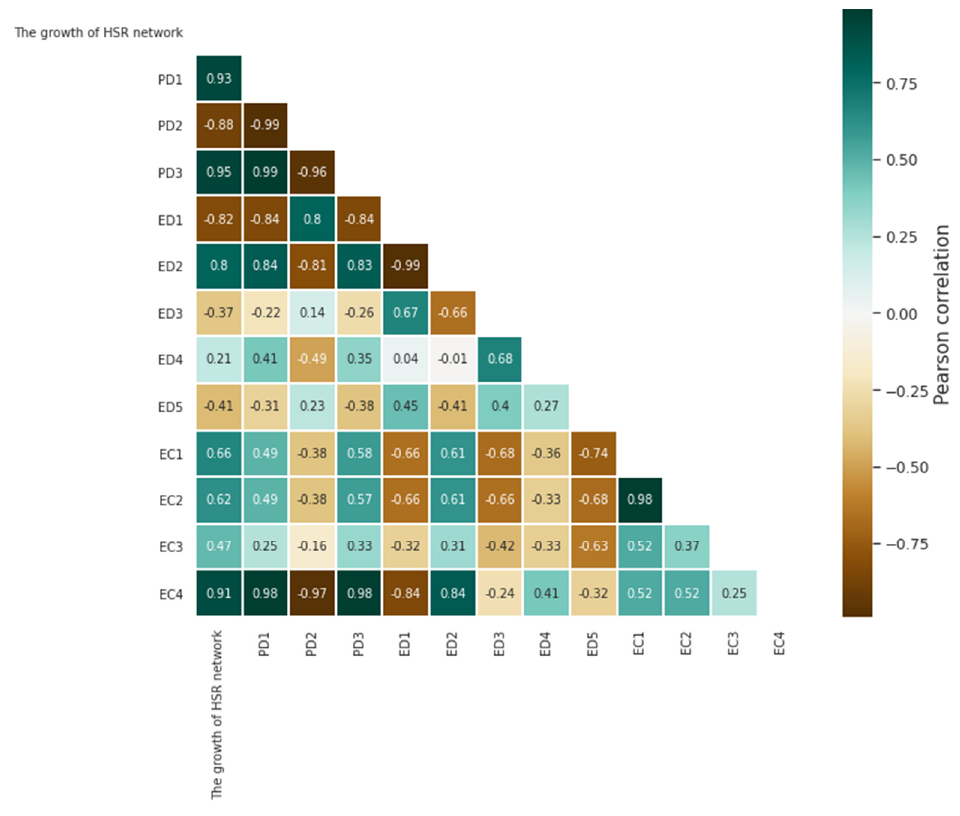
Figure 6. The PCC’s outcome of the Korail network.